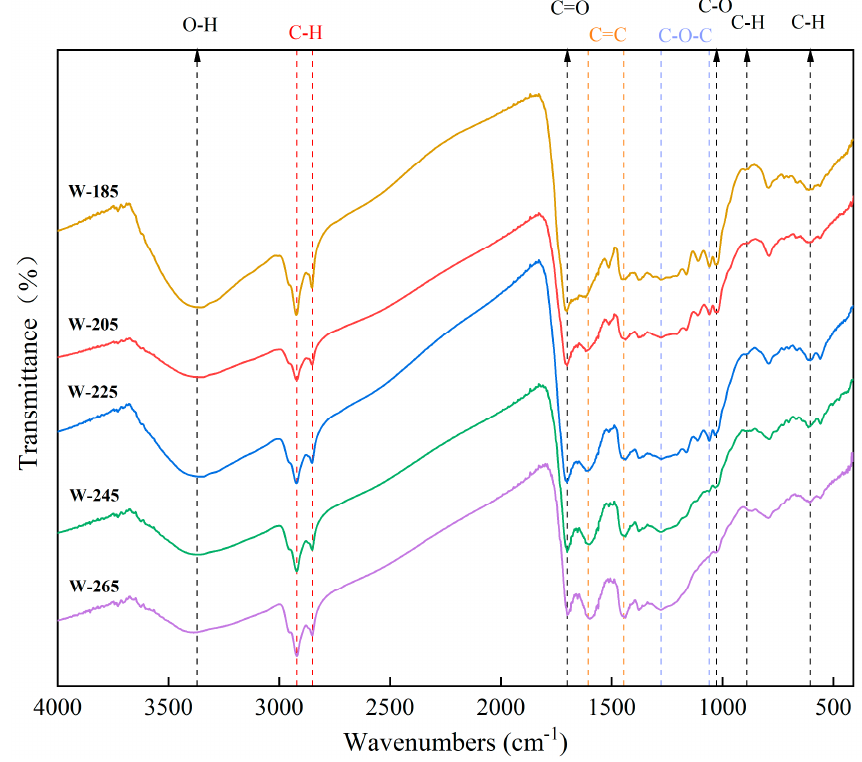
Figure 5. Fourier Transform Infrared (FT-IR) spectra of hydrochar at di ff erent HTC temperatures.